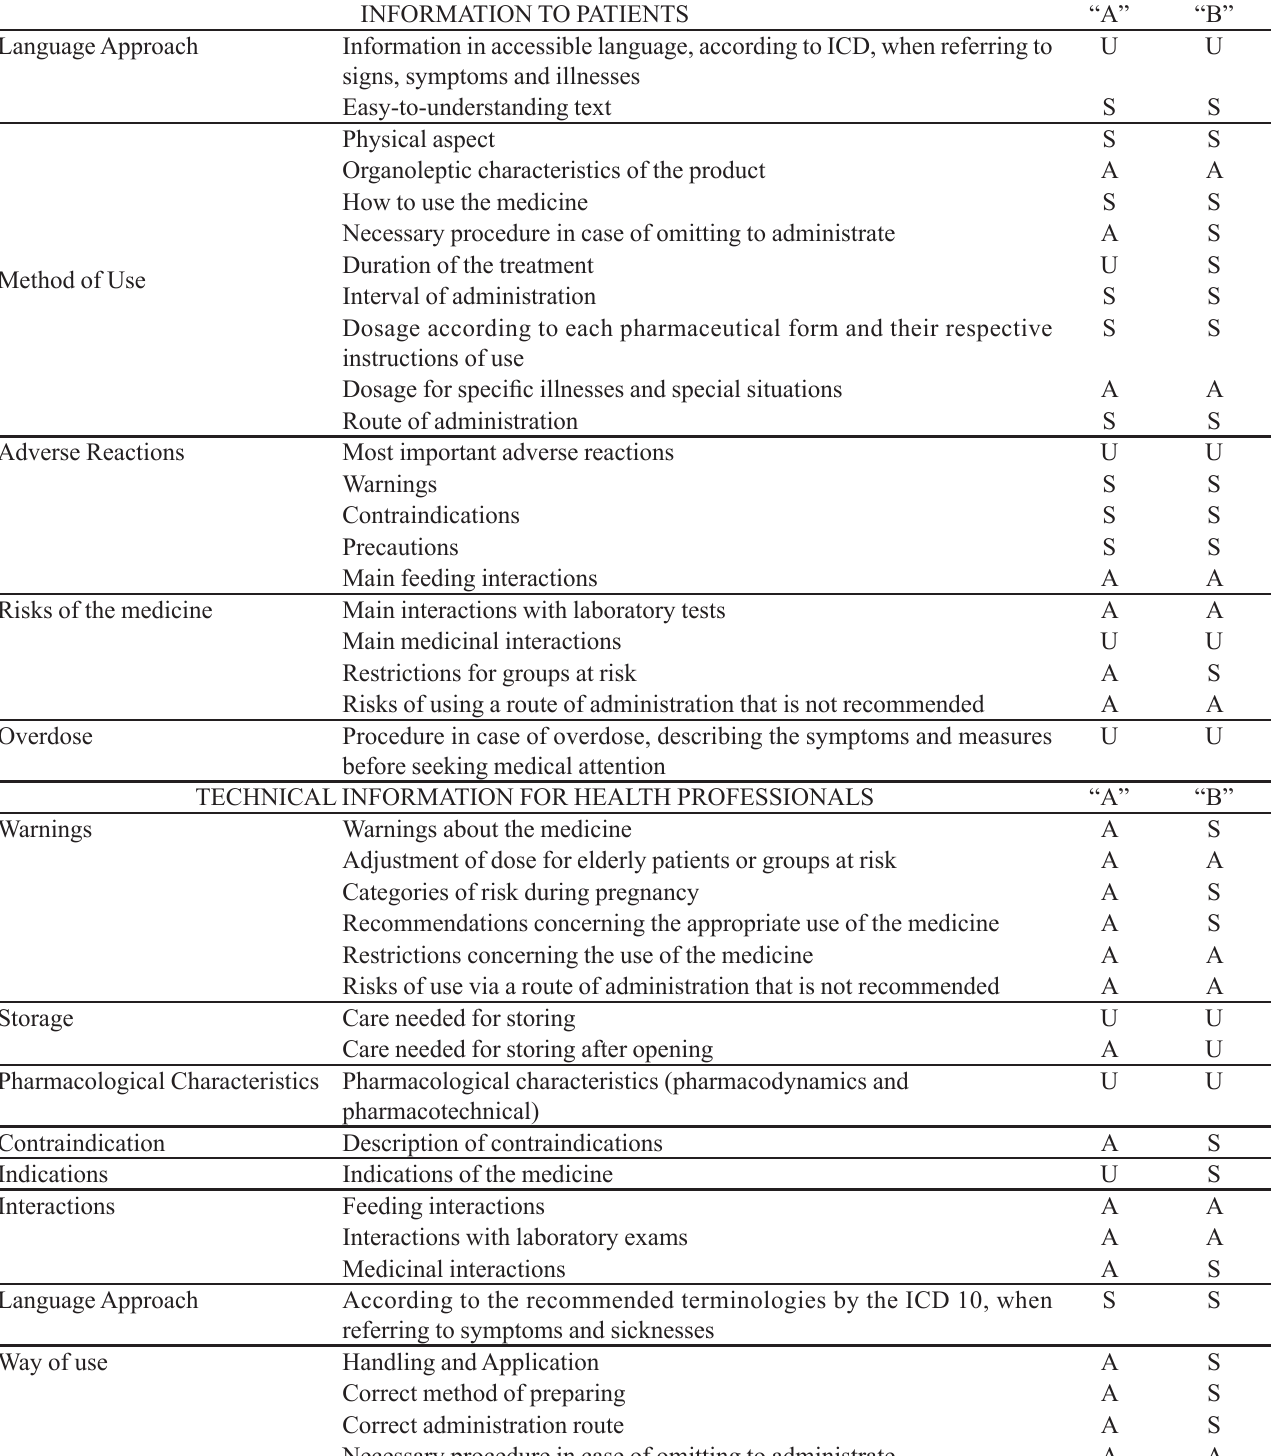
TABLE I – Standard form for evaluation of package inserts according to RDC 140/2003, employed in the verification of package inserts of P. sidoides medicines produced by manufacturers “A” and “B”